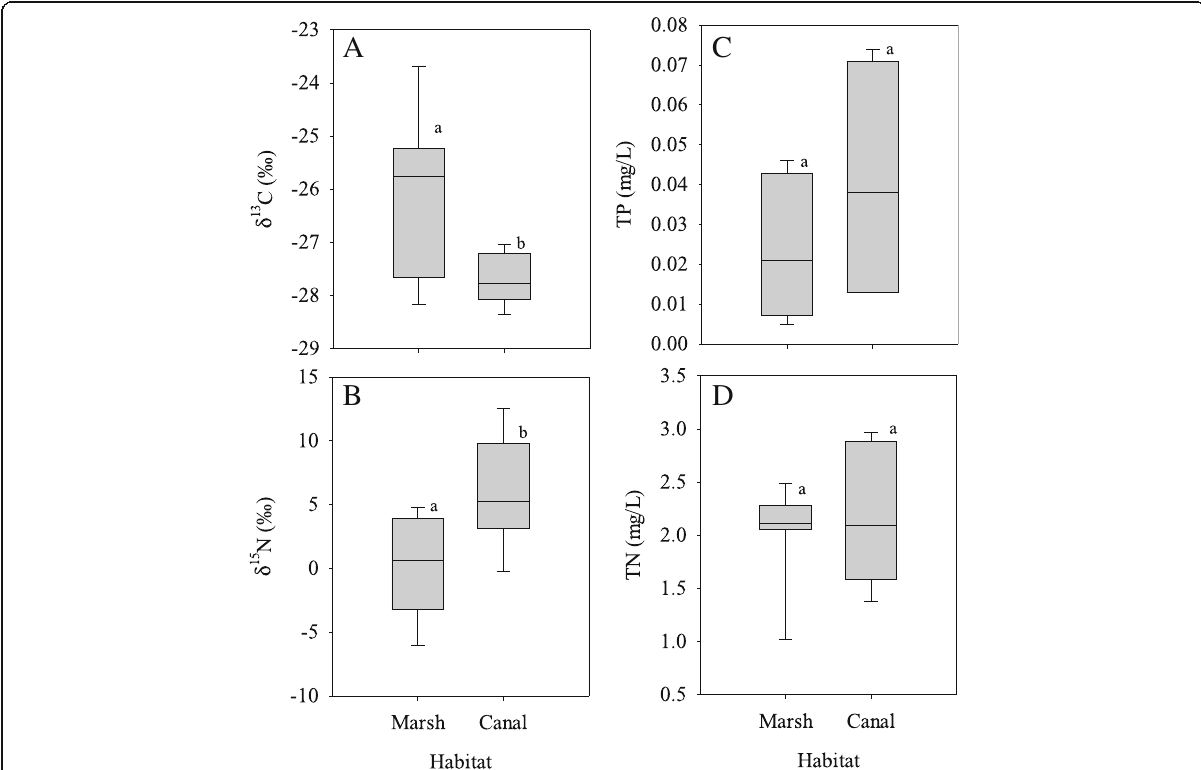
Fig. 4 Cattail δ 13 C ( a ) and δ 15 N ( b ), and surface water TP ( c ) and TN ( d ) in marsh ( N = 8) and canal sites ( N = 6) from south Florida. Different letters denote significant